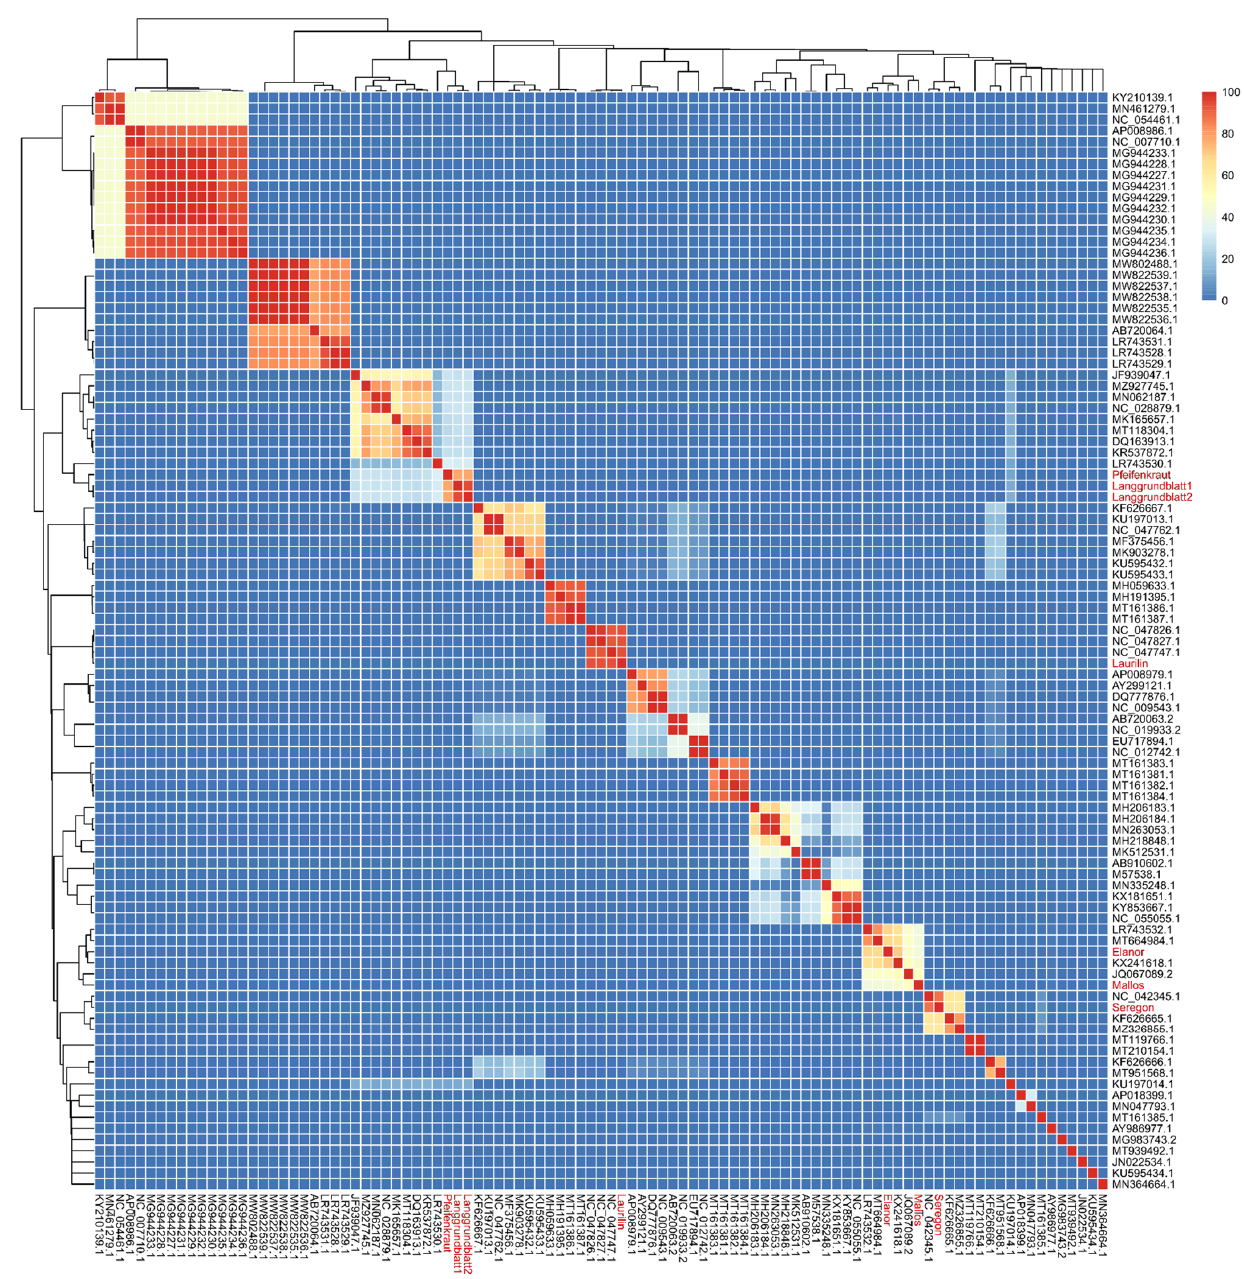
Figure 5. Average nucleotide-based dendrogram analysis using 97 phage genomes of phages infecting Xanthomonas species. Genomes are derived from [6] or Virus Host DB (https://www.genome.jp/virushostdb/, accessed on 19 January 2022). Furthermore, 11 genomes were acquired from NCBI based on similarity to our seven novel